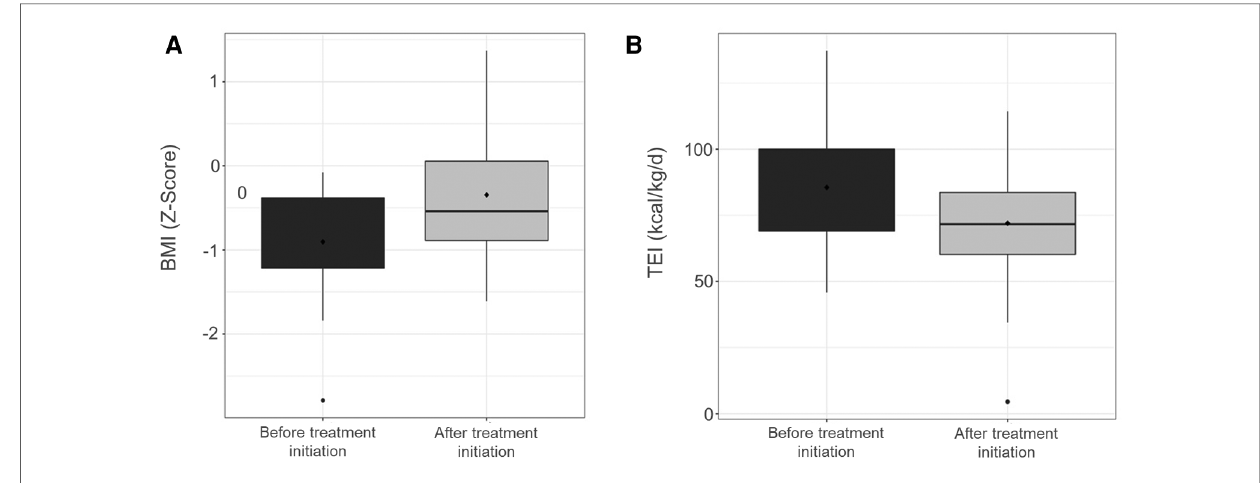
FIGURE 1 Z-score changes in body mass index ( A ) and total energy intake ( B ) under